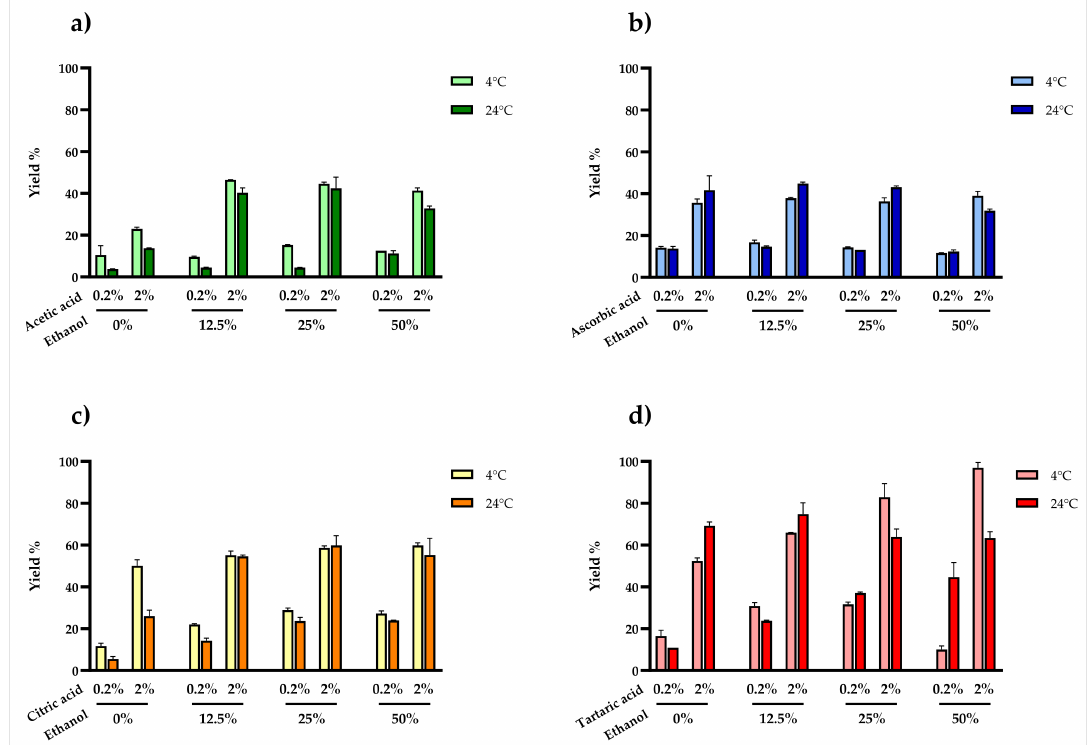
Figure 4. Anthocyanin yields were obtained at two different temperatures (4 or 24 ◦ C), with four concentrations of ethanol (0%, 12.5%, 25%, and 50%) and four different types of organic acid (acetic ( a ), ascorbic ( b ), citric ( c ) and tartaric ( d )) at two different concentrations (0.2% and 2.0%). Values are percentages (yield %) relative to the gold-standard method. Data are means ± SD (two replicates at each combination of factor levels, randomization of the run